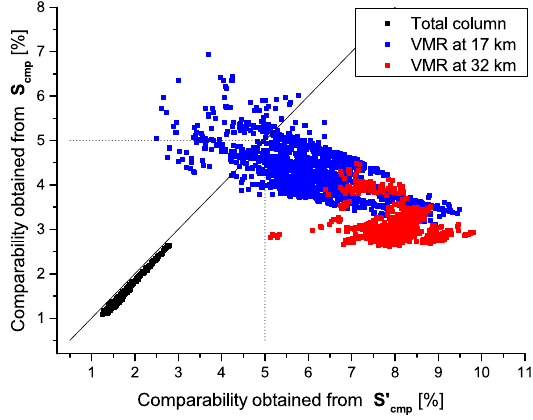
Figure B3. Comparability between the UNAM and Altzomoni re- mote sensing data, calculated according to Eqs. (8) and (B2). Shown the values for three products: the total column amounts (black), the VMRs at 17km and the VMRs at